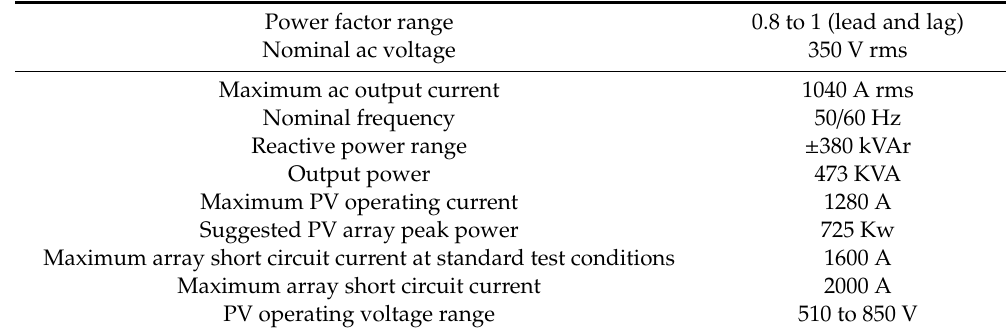
Table A2. The parameters of inverter-based